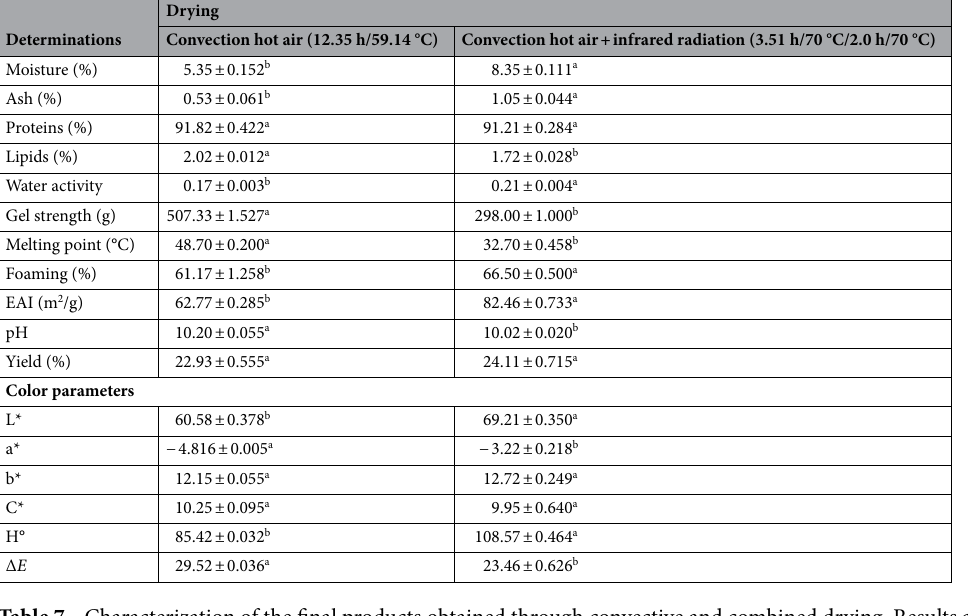
Table 7. Characterization of the final products obtained through convective and combined drying. Results are mean ± standard deviation. Different letters in the same line indicate statistical significant difference (p ≤ 0.05). EAI emulsion activity